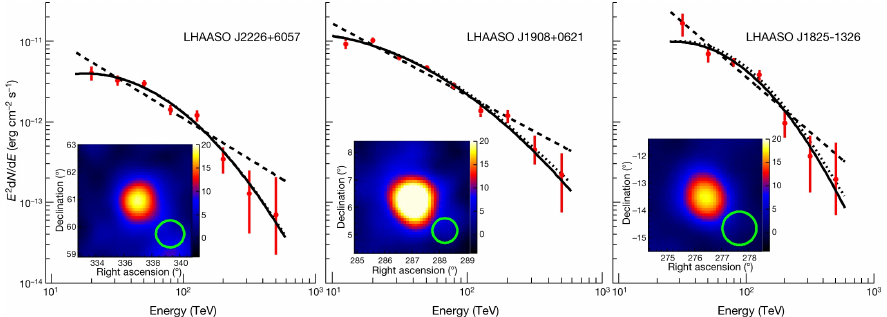
Figure 8. Spectral shapes of three of the Galactic Plane sources observed by the LHAASO Collabora- tion extending up to several hundreds of TeV. Figure from